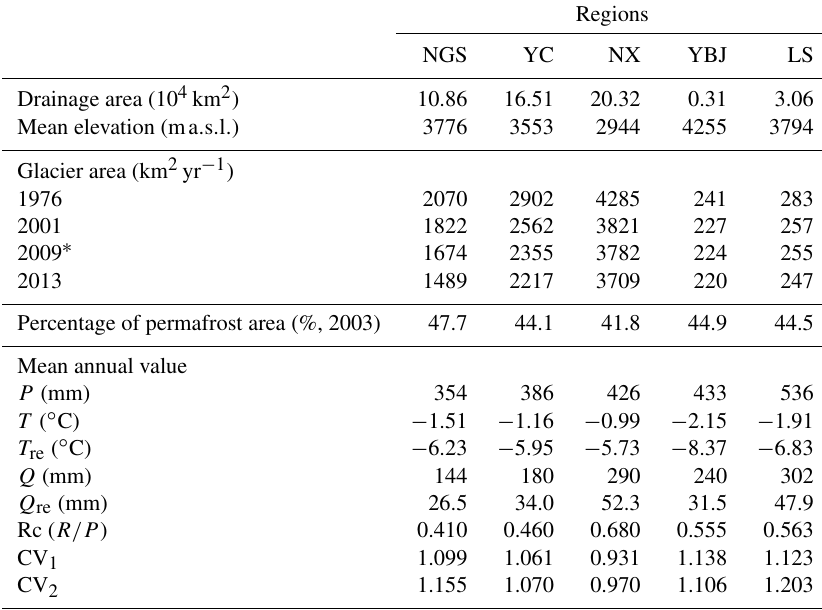
Table 2. Summary of subbasin characteristics in the YR